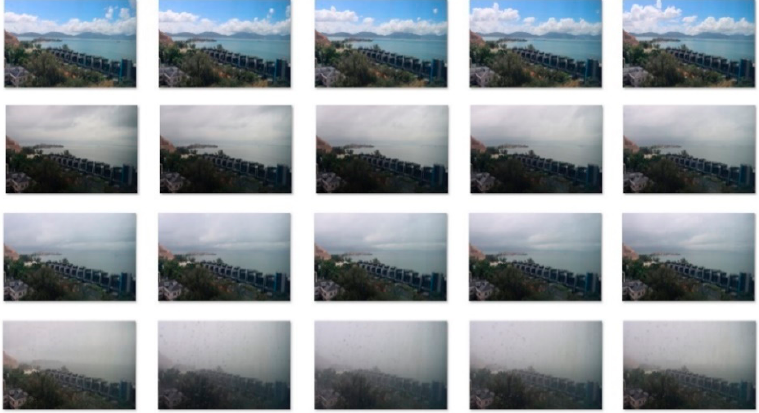
Figure 4. Samples of the database images.